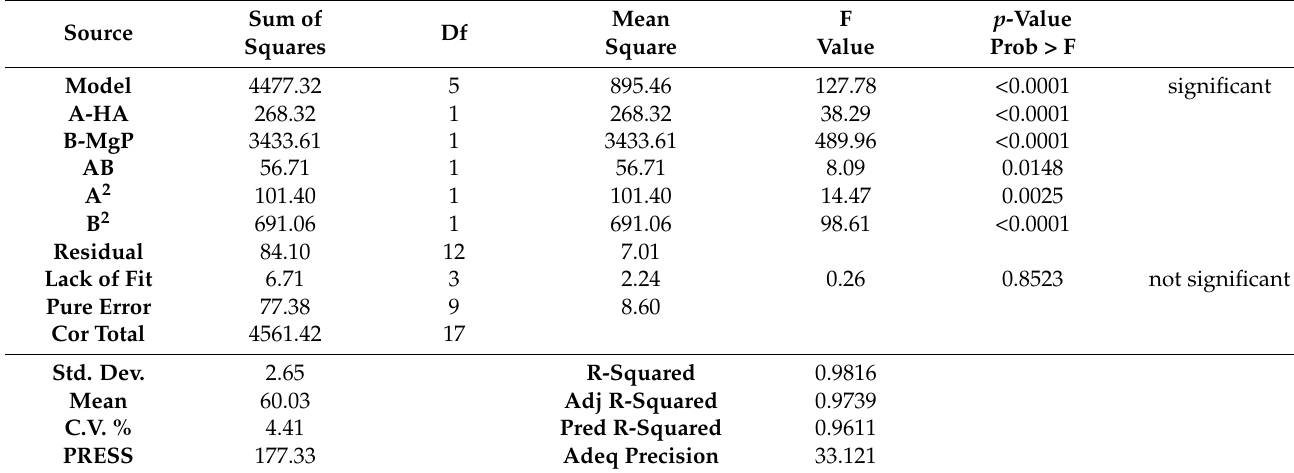
Table 3. ANOVA table for the quadratic model (UCS).